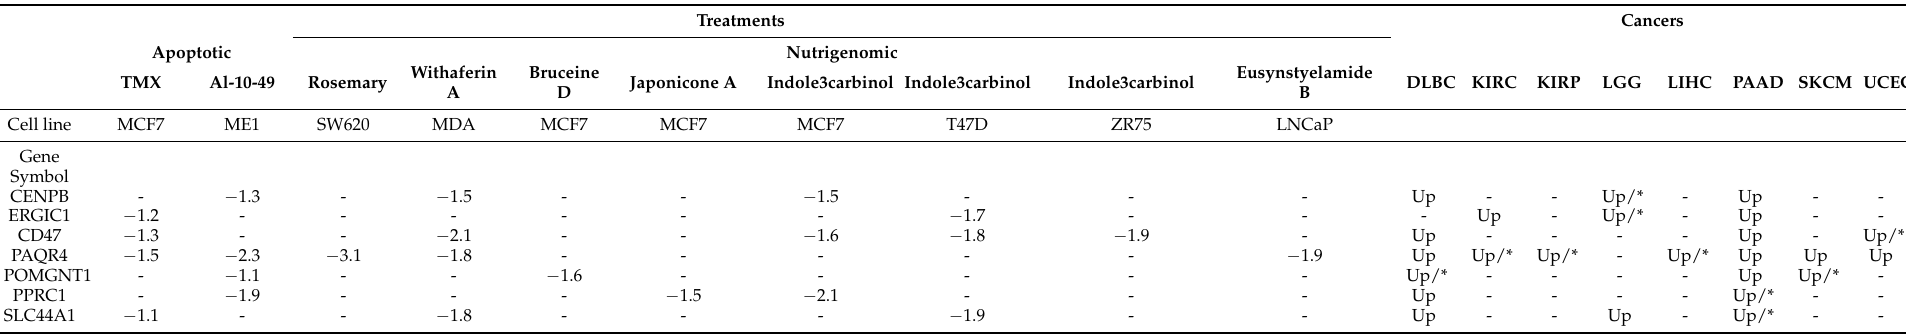
Table 1. List of the 7 genes with confirmation of enhanced survival rate in cancer types and expression patterns in apoptotic, nutrigenomic and